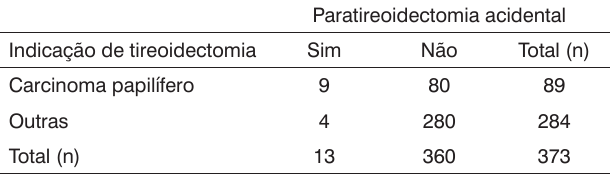
Tabela 2. Ocorrência de paratireoidectomia acidental em tireoidectomias em relação ao carcinoma papilífero da glân- dula